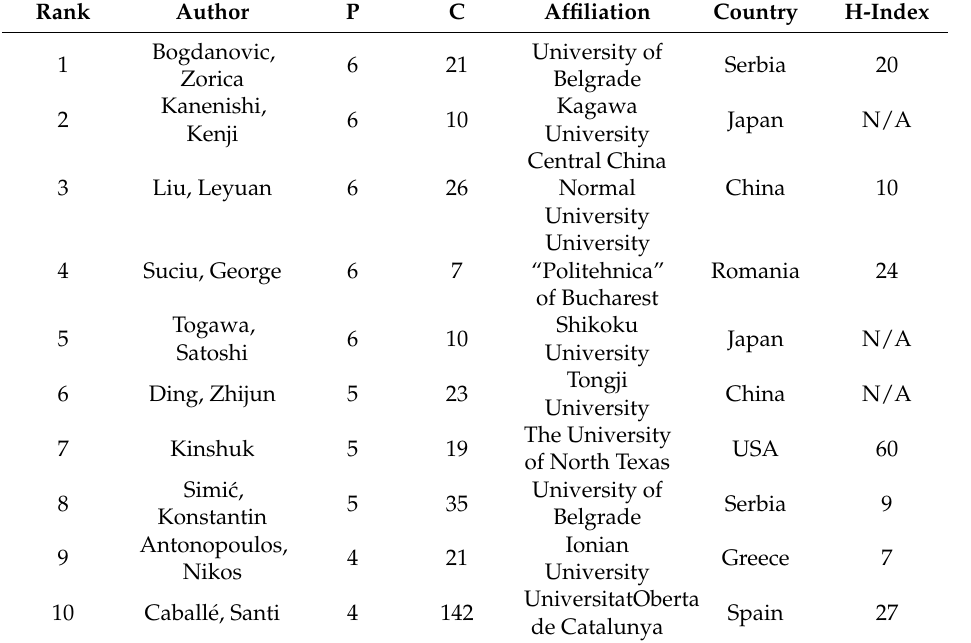
Table 4. Most prolific